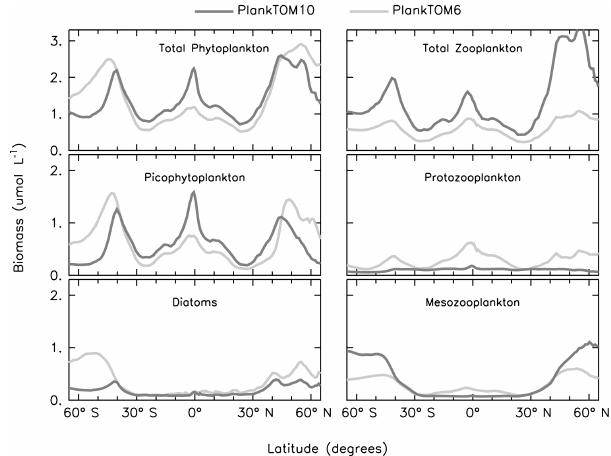
Figure 9. Zonal mean distribution of phytoplankton (left) and zoo- plankton (right) PFTs for the PlankTOM10 (dark grey) and Plank- TOM6 (light grey) models (µmolCL − 1 ) .